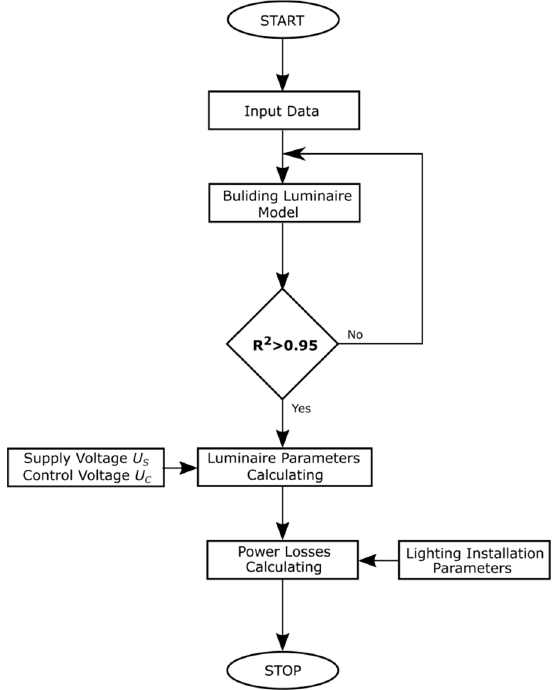
Figure 6. Algorithm for determining total losses in elements of the lighting system.